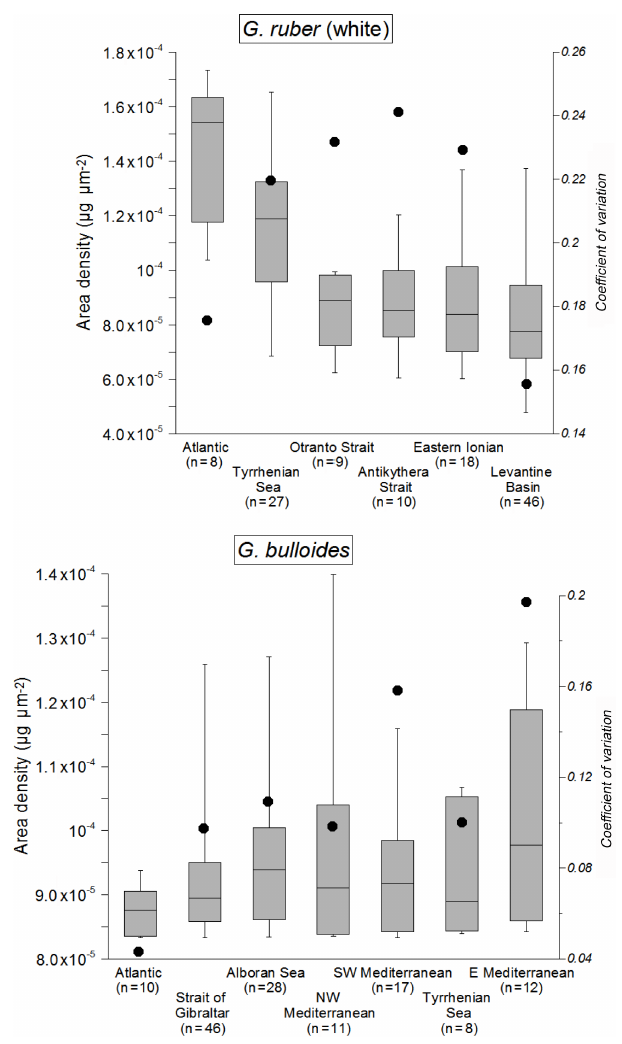
Figure 7. Area density of G. ruber (white) and G. bulloides in box- and-whisker plots representation for the different location group- ings in the Mediterranean. Box extends from the lower- ( Q 1 ) to upper- ( Q 3 ) quartile values of the data, with a line at the me- dian ( Q 2 ) . Whiskers extend from the quartiles to values com- prised within a 1.5 interquartile range (IQR = Q 3 − Q 1 ) – distance: Q 1 − 1 . 5 · IQR; Q 3 + 1 . 5 · IQR. The coefficient of variation (CV) of each location grouping is represented as a black